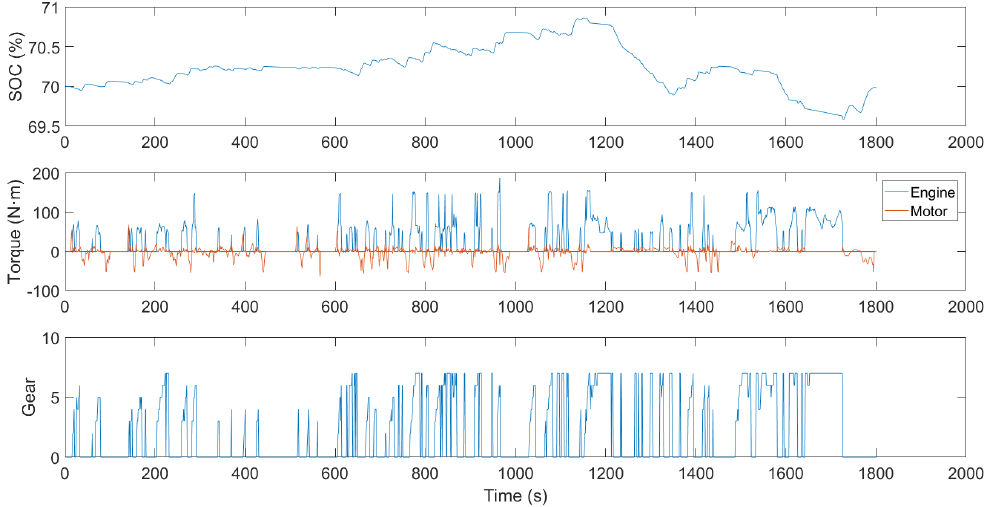
Figure A2. Three state parameters’ variation curves of 𝜇 (cid:3040)(cid:3036)(cid:3041) for emission NOx.